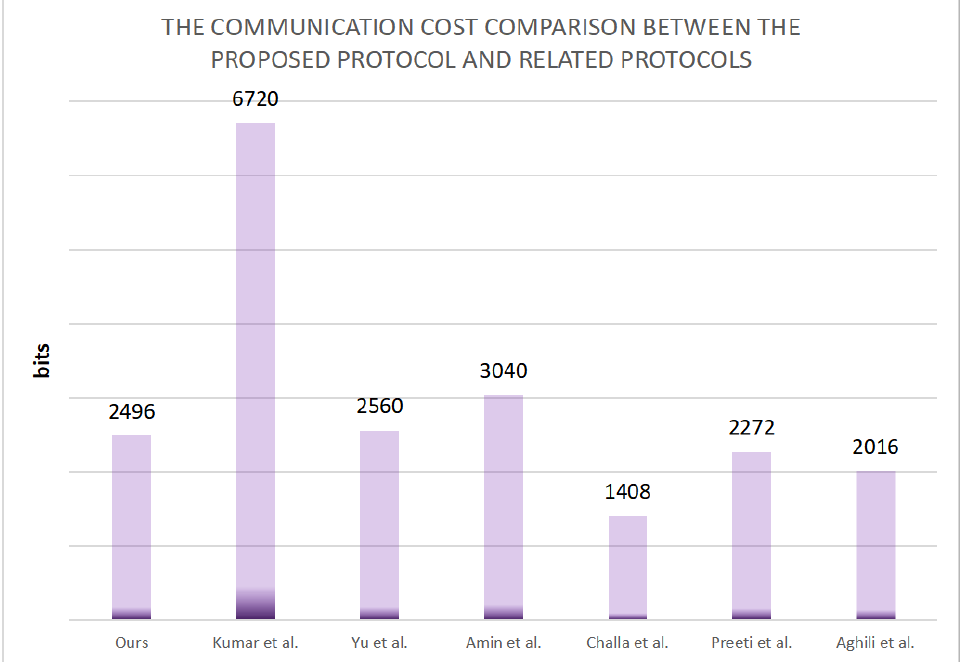
Figure 6. Communication